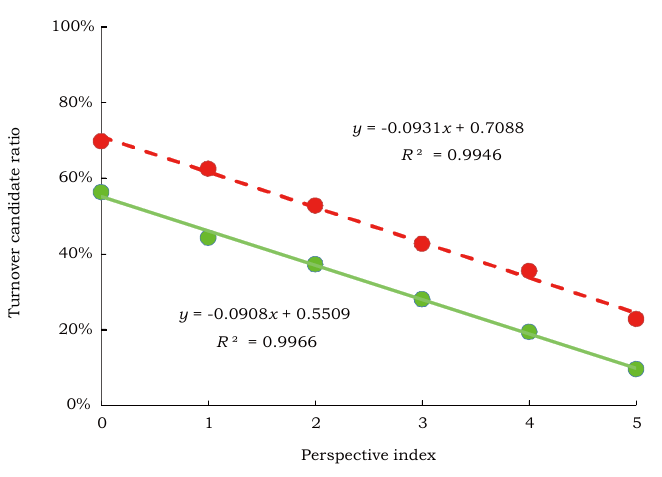
Figure 4. Perspective index and turnover candidate